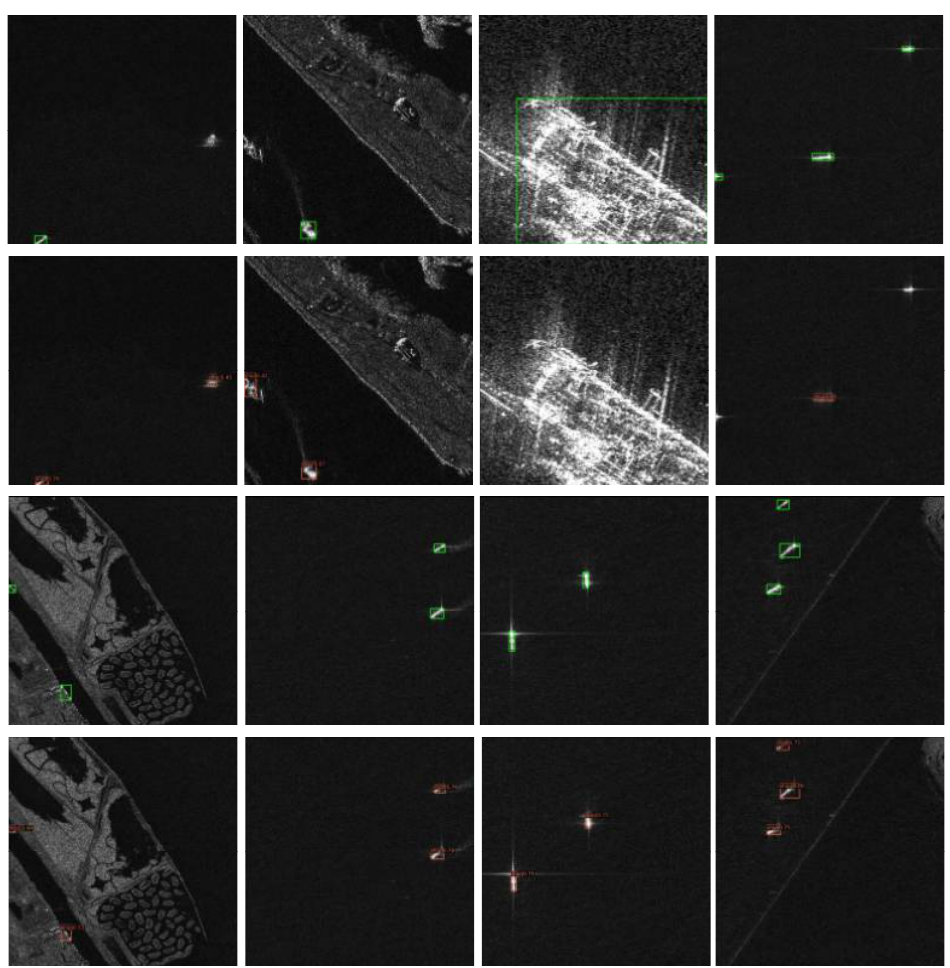
Figure 2. Detection results of FCOS + ATSS on HRSID. The green rectangles and red rectangles are the ground truth and detection results, respectively.